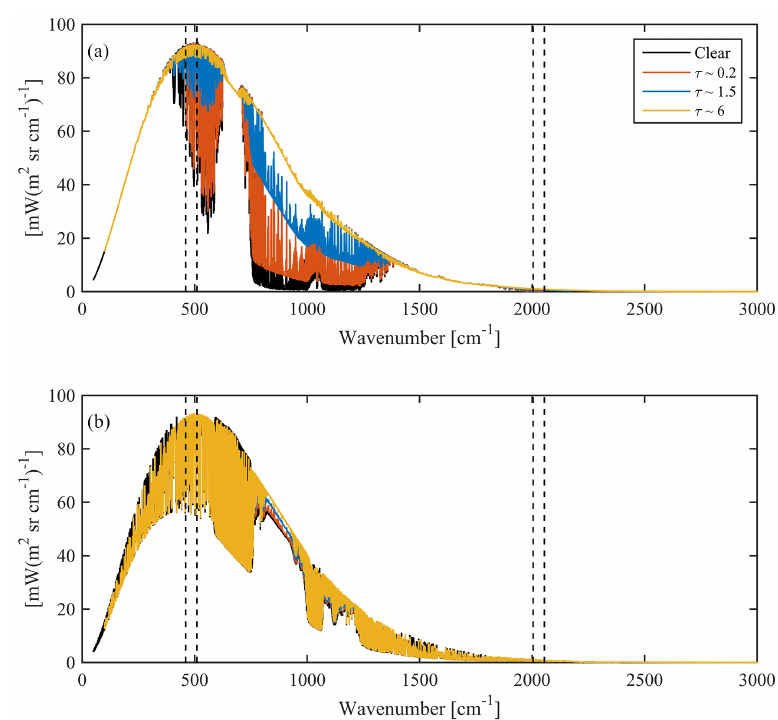
Figure 8. Example simulated radiances for (a) downwelling from the perspective of the surface and (b) same case as (a) , but for upwelling radiances from the perspective of the top of the atmosphere. Channel edges and channel overlap between channel 1 and channel 2 are marked by vertical dashed lines near 500cm − 1 and similarly near 2000cm − 1 for channel 2 and channel 3. Each panel shows line-by-line clear-sky radiances (black) and 0.01cm − 1 resolution spectra for three example clouds with optical depths of approximately 0.2 (red), 1.5 (blue), and 6